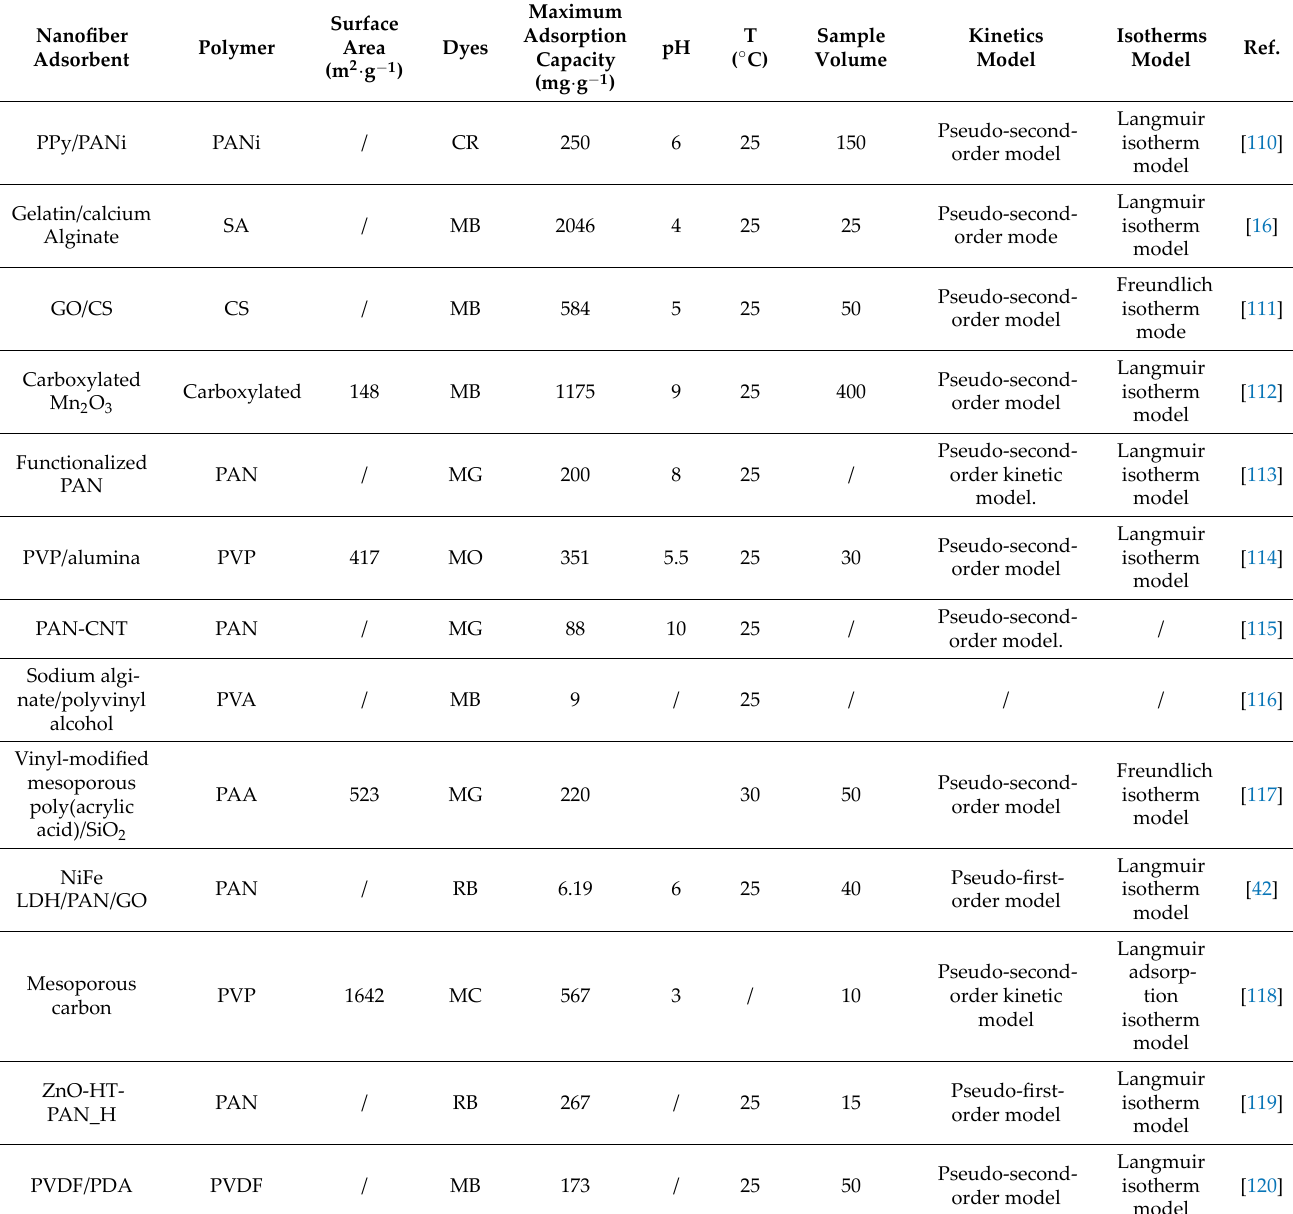
Table 3. The adsorption performance of other nanofiber adsorbents for